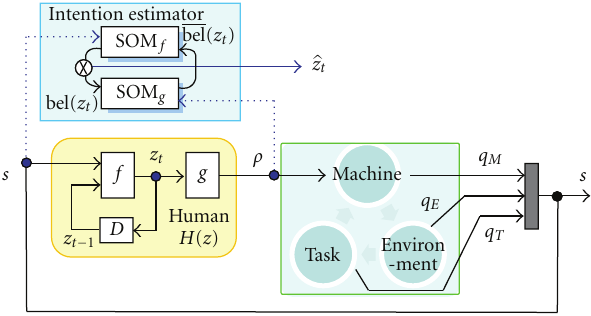
Figure 3: Block diagram involving a human model and the intention estimator in human-machine